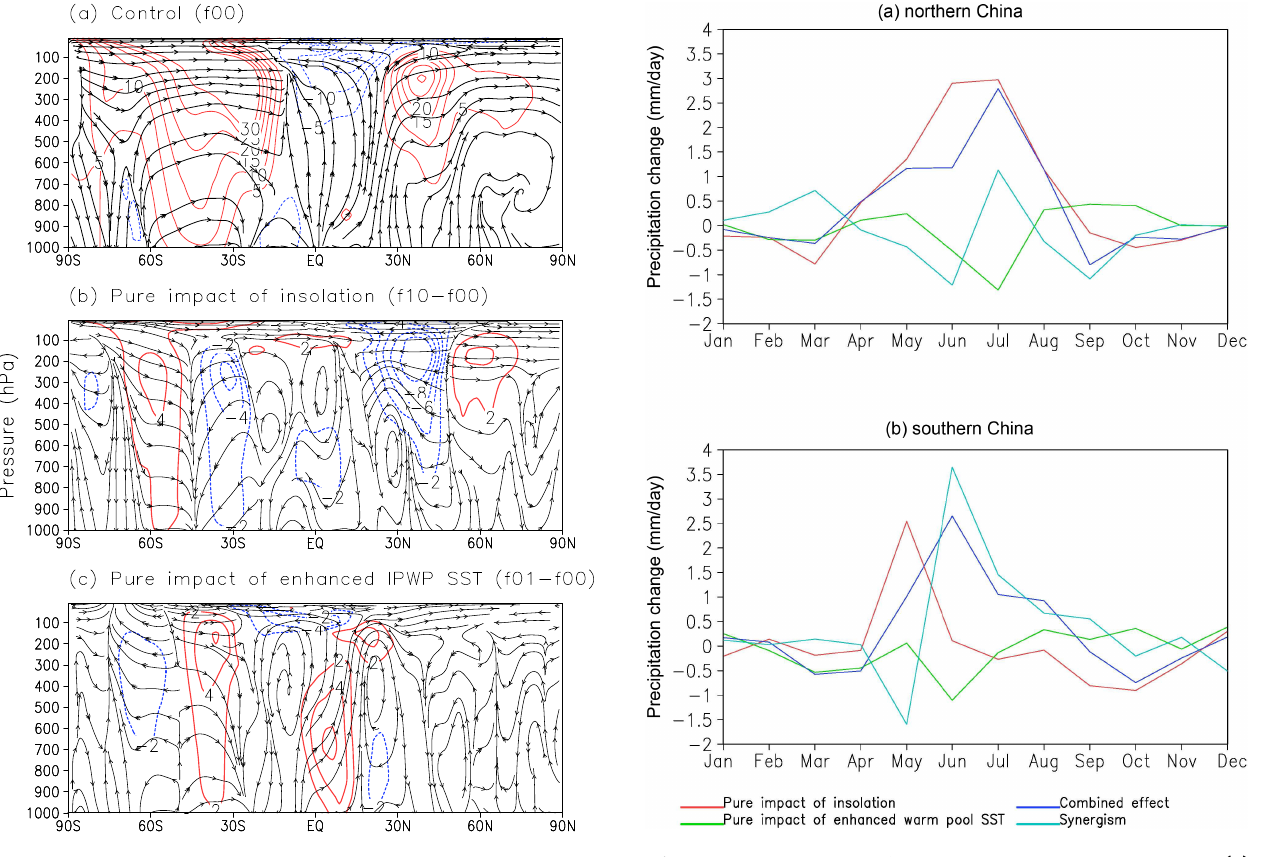
Figure 5. JJA mean meridional wind circulations averaged over 105 to 120 ◦ E. (a) The control experiment ( f 00 ), (b) the pure impact of insolation ( f 10 − f 00 ), and (c) the pure impact of enhanced IPWP SST ( f 01 − f 00 ). Stream lines indicate meridional wind circulation for (a) and anomalies for (b) and (c) . Contour lines indicate zonal wind circulation (with an interval of 5ms − 1 for a ) or anomalies (with an interval of 2ms − 1 for b and c ).